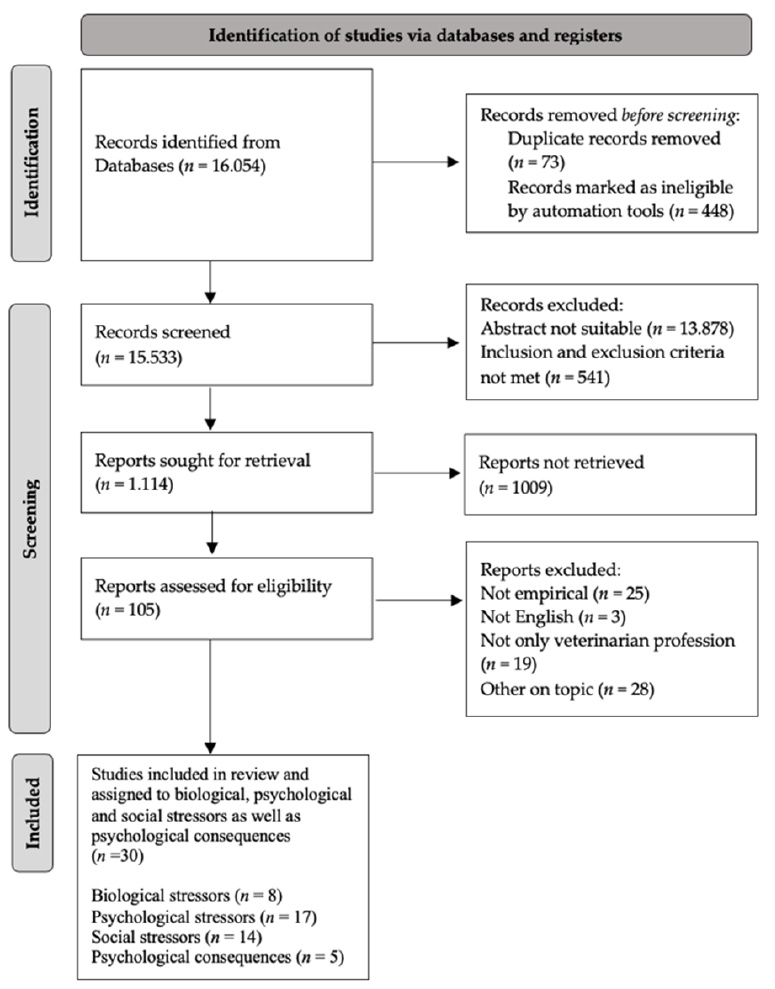
Figure 1. Figure 1. Flowchart.